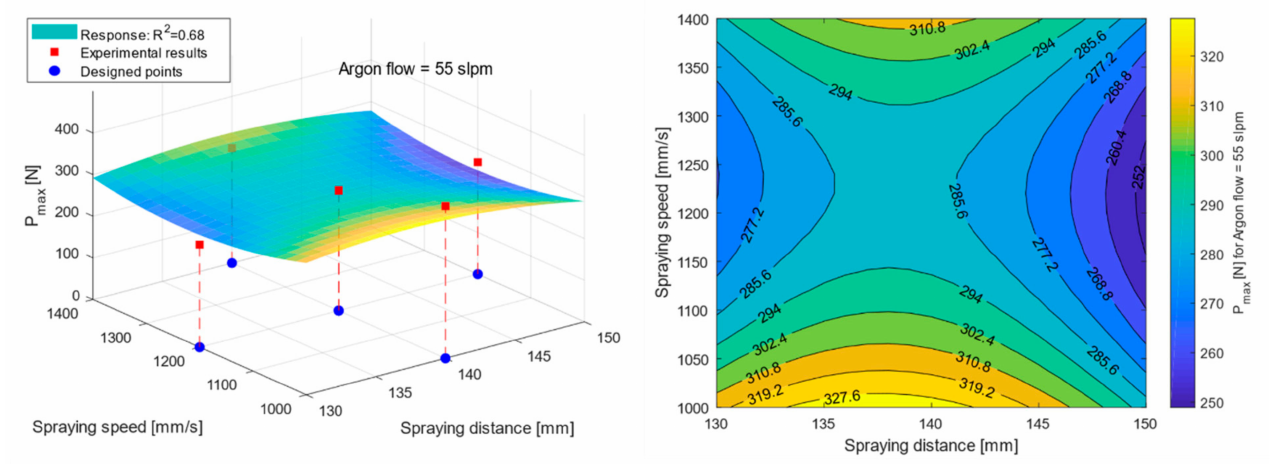
Figure 5. Response surface of the obtained P max for a fixed argon flow rate of 55